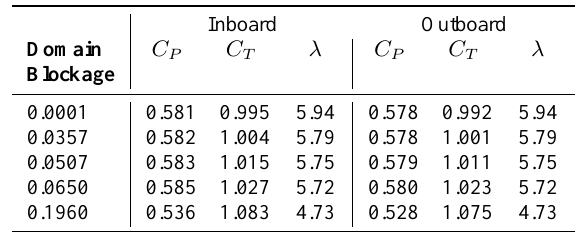
TABLE III R OTOR POWER COEFFICIENT AND CORRESPONDING TIP SPEED RATIO AND THRUST COEFFICIENT FOR THE FIVE ROTOR DESIGNS IN THE MULTI - ROTOR FENCE CONFIGURATION WHEN FENCE POWER IS MAXIMISED .